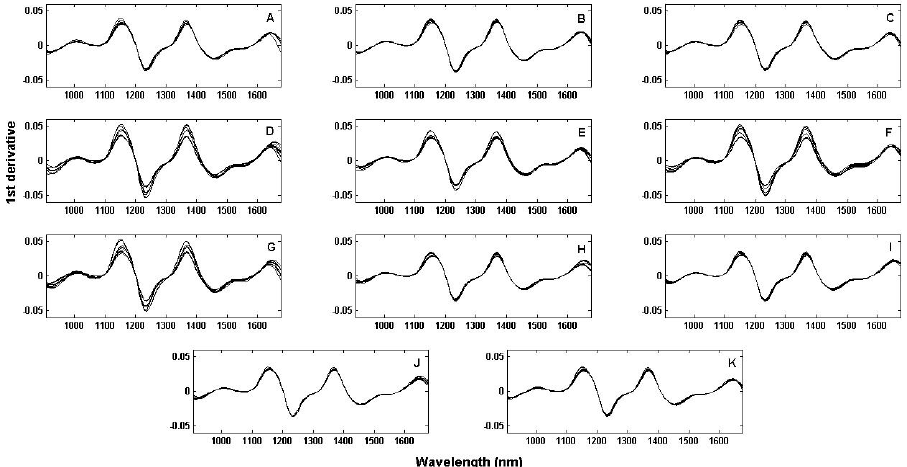
Figure 1. NIR spectra: ( A ) Control (i.e., antioxidant-free soybean oil); ( B ) BHT; ( C ) TBHQ; ( D ) Provençal herbs extract; ( E ) Dehydrated goji berry extract; ( F ) Pumpkin seed extract; ( G ) Poppy seed extract; ( H ) Provençal herbs; ( I ) Dehydrated goji berry; ( J ) Pumpkin seed; ( K ) Poppy seed.